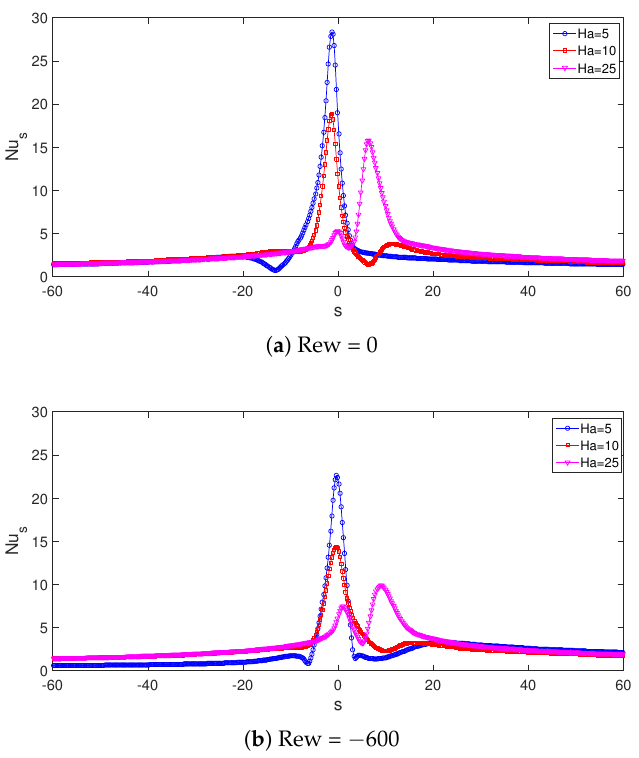
Figure 7. Impact of MaF strength on local Nu variations at two Rew (Da = 5 × 10 − 2 ,Mx = − 1, AR =